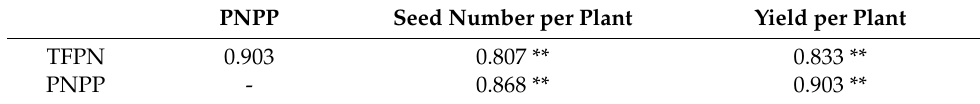
Table 1. Correlation coefficient among TFPN, PNPP, and yield-related traits in soybean.